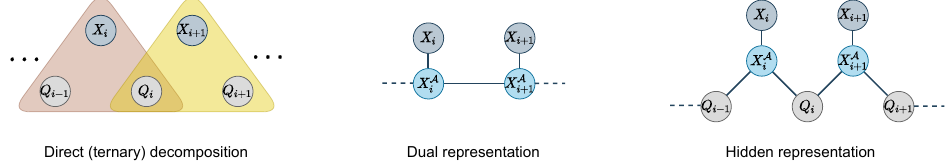
Figure 5. Representation of the ternary decomposition, and its dual and hidden representations. The hidden representation of a constraint network X = ( X , D , C ) is a network X (cid:48)(cid:48) = ( X (cid:48)(cid:48) , D (cid:48)(cid:48) , C (cid:48)(cid:48) )